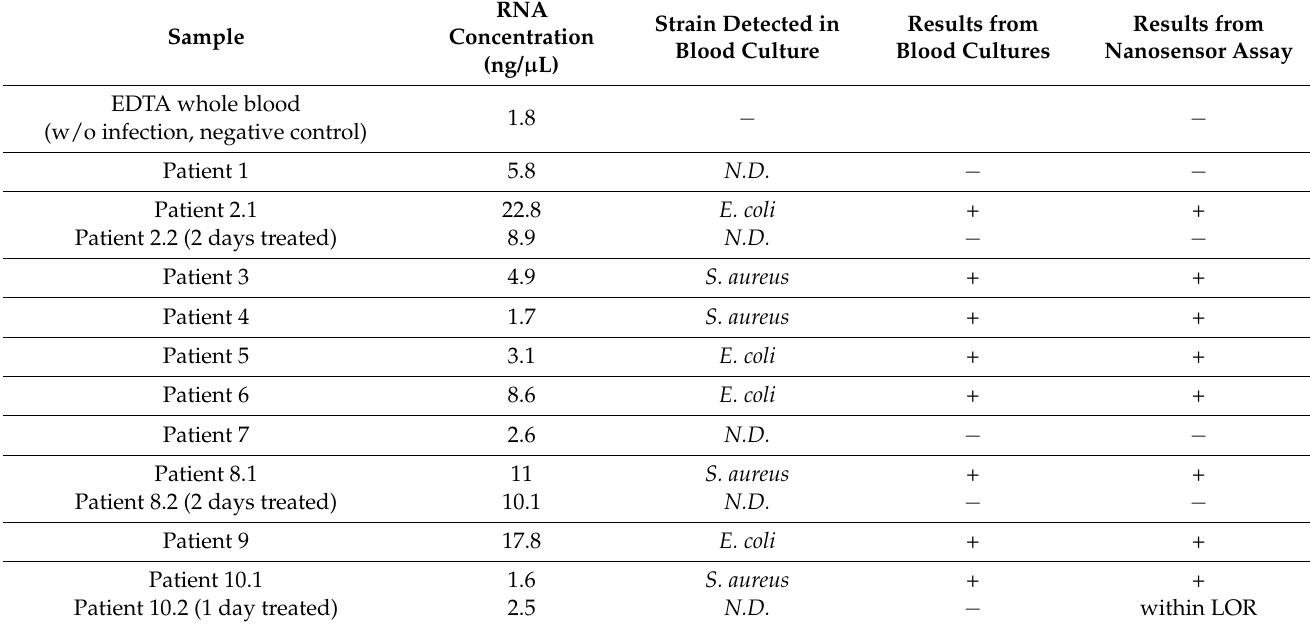
Table 2. Concentrations of total RNA extracted from EDTA whole blood of 10 different patients and determined bacteremia state. Human EDTA whole blood without bacteremia is used as a control. The various colours correspond with the colours in Figure 5. (+) indicates patient samples with bacterial infection before treatment and ( − ) after treatment diagnosed free of bacterial infection as determined in blood culture based diagnostics (reference standard). N.D.: not